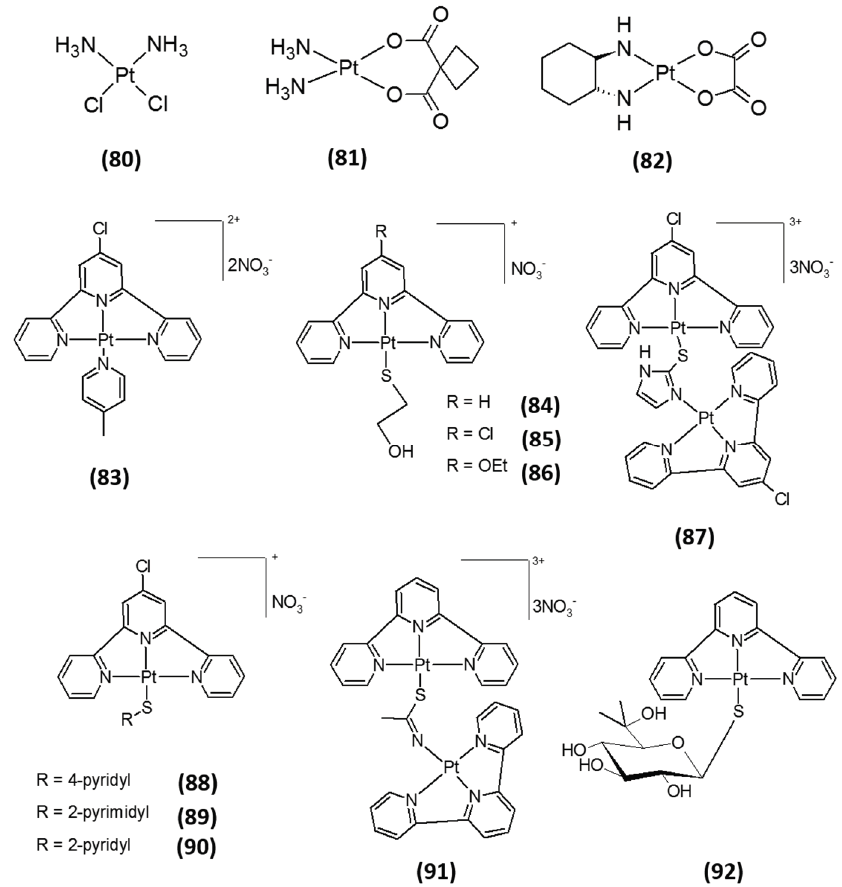
Figure 5. Structures of platinum(II)-based